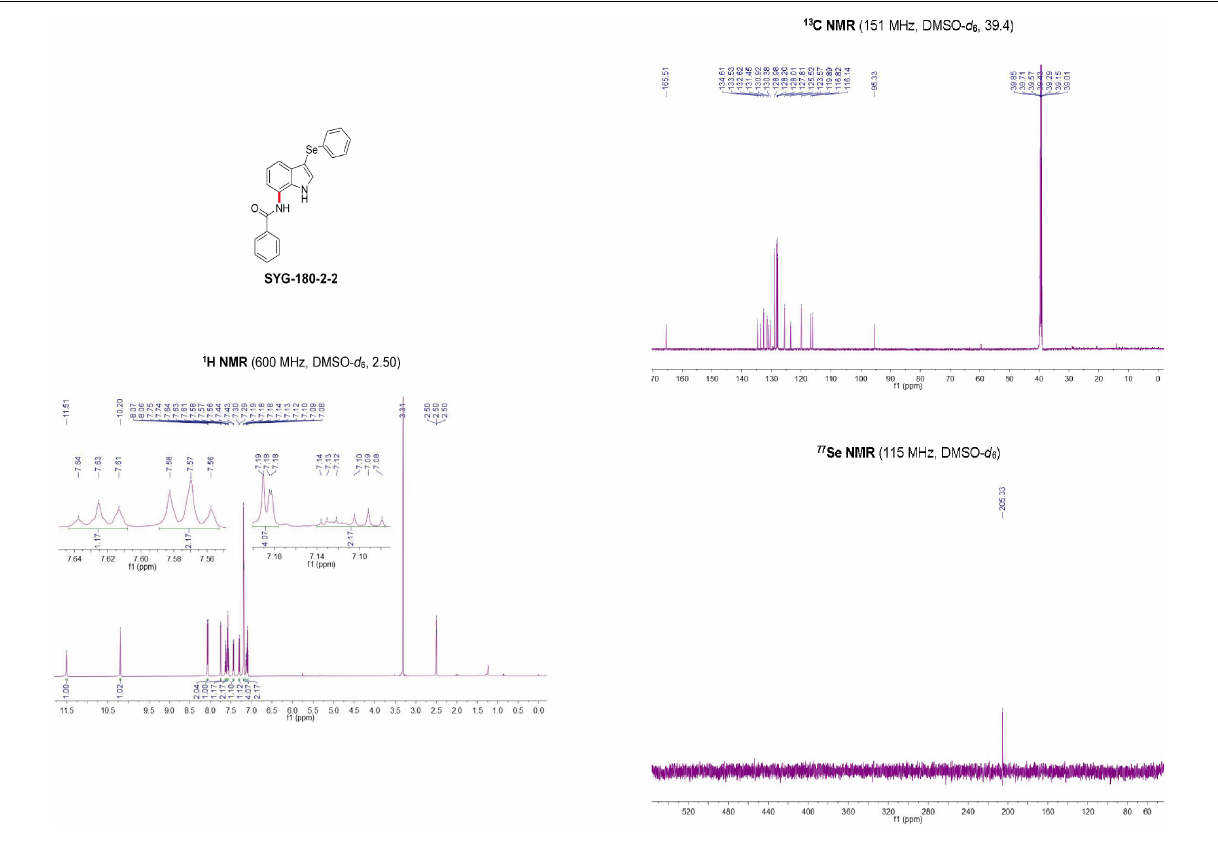
FIGURE 2 | Nuclear magnetic resonance (NMR) identification of